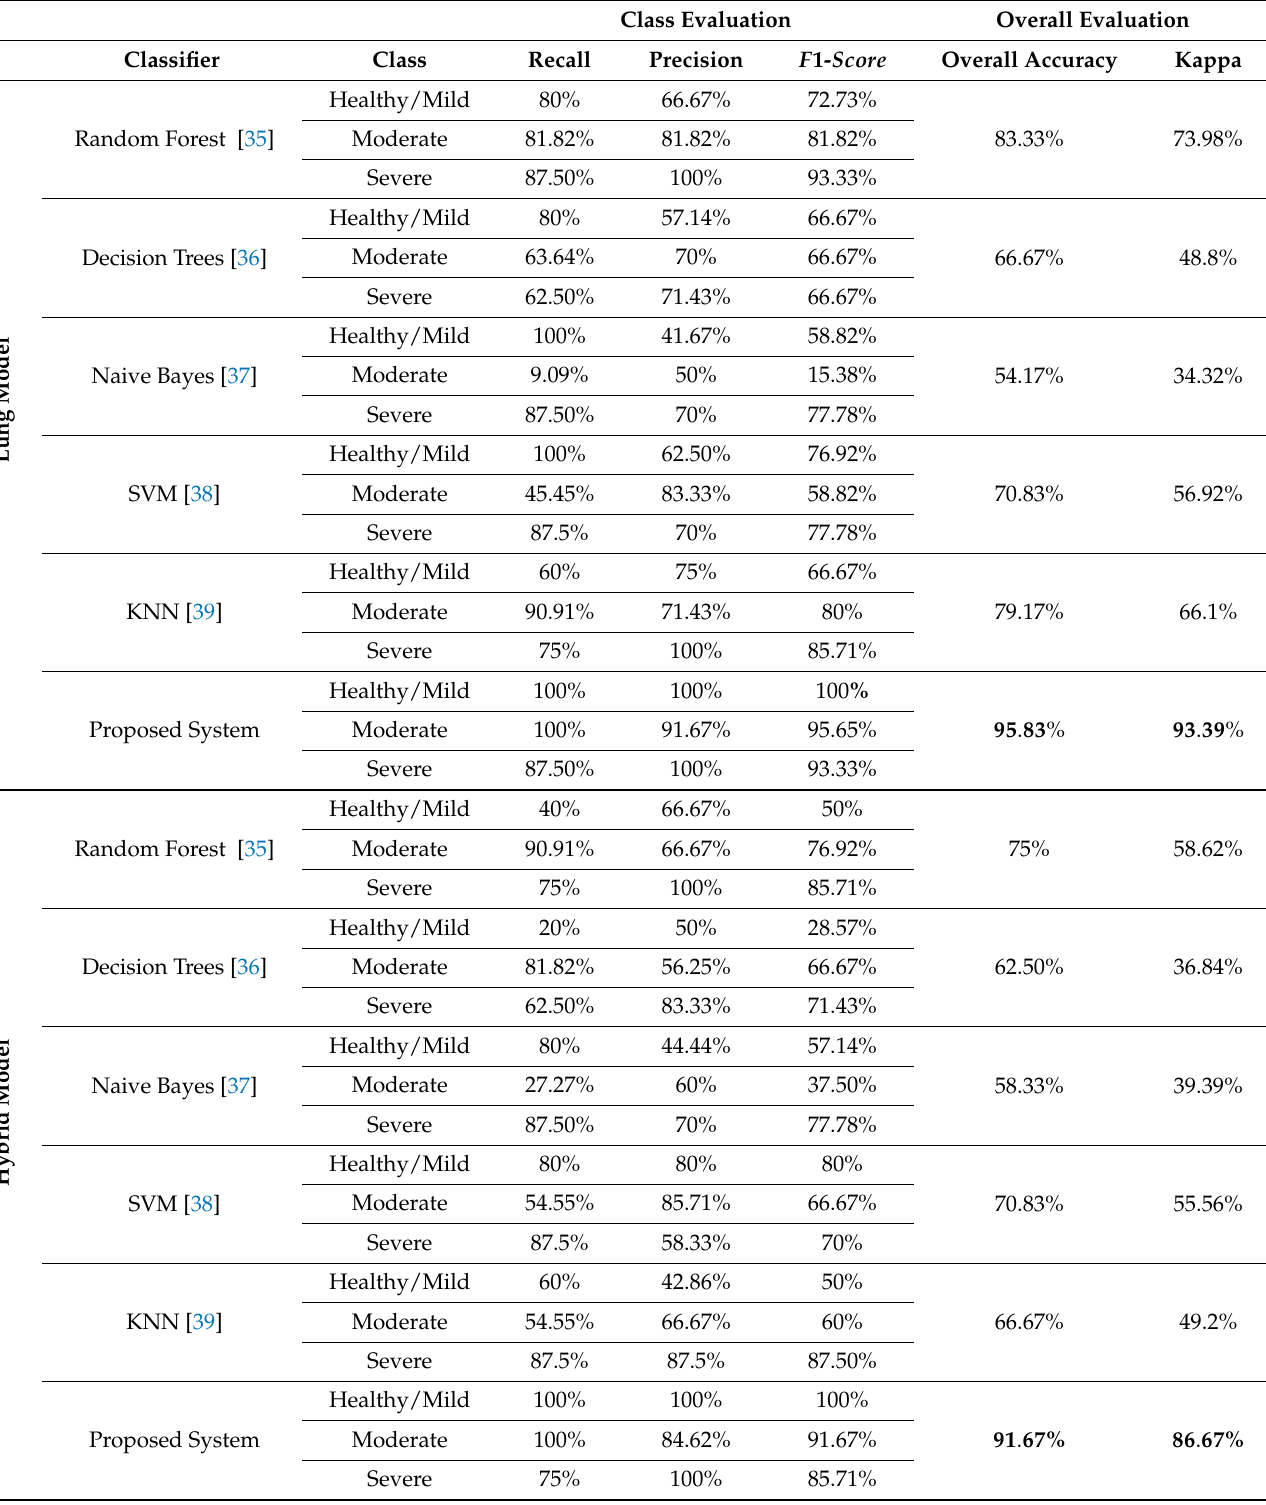
Table 1. Comparison between the proposed system and different machine learning classifiers using lung, hybrid, and lesion